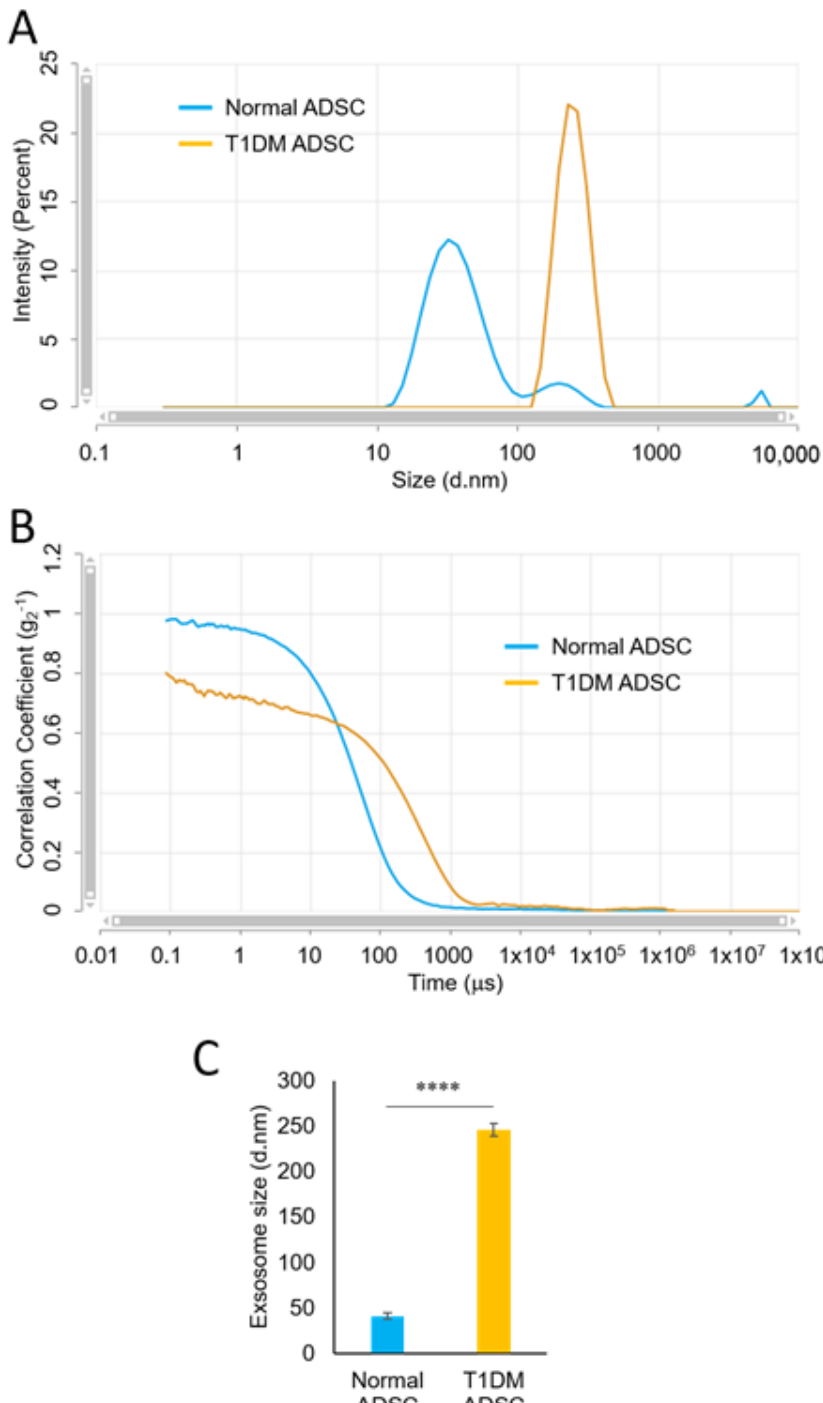
Figure 3. Exosome particle diameters of adipose-derived mesenchymal stem cells (ADSCs). Results of particle size measurements of ADSC exosomes. ( A ) A graph showing size distribution by intensity measured with a Zetasizer. ( B ) A correlogram generated using a Zetasizer. ( C ) Mean particle diameters of exosomes extracted from normal and adipose-derived stem cells of patients with type 1 diabetes mellitus (T1DM ADSCs). The values shown in the graph are in the form of mean ± SD. The number of samples is n = 5. Three independent evaluations were performed. Shapiro–Wilk and unpaired t -tests were used for statistical analysis. **** The p -value < 0.0001.